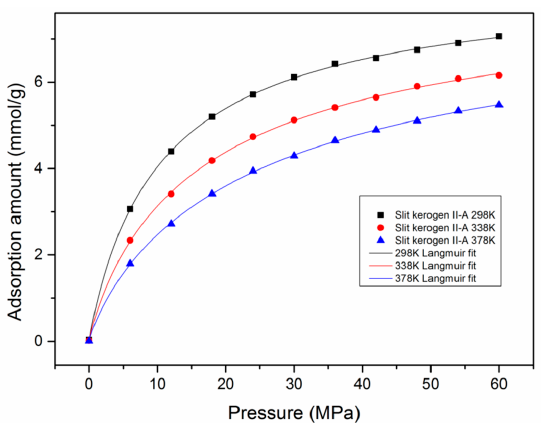
Figure 9. The adsorption isotherms of pure CH 4 and Langmuir fitting in a type II-A slit kerogen nanopore with a pore size of 2 nm at different temperatures.